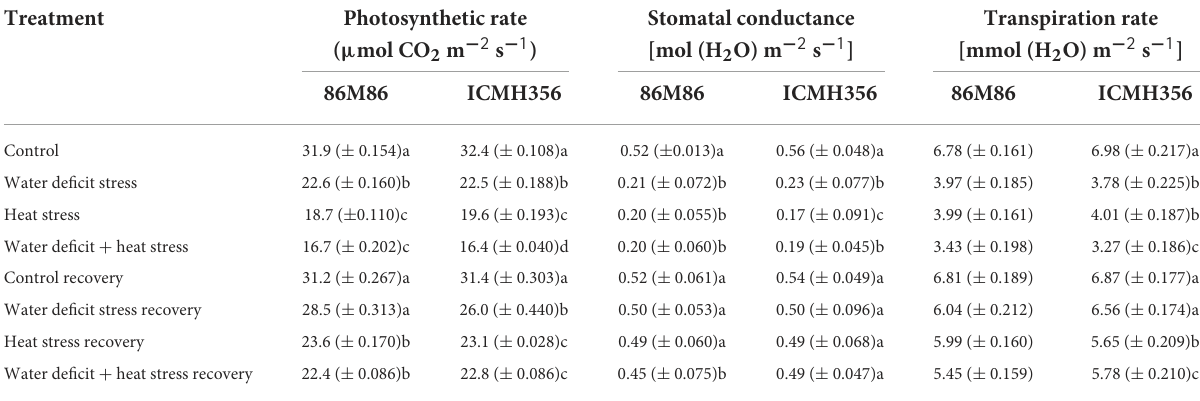
TABLE 2 The photosynthetic rate and gas exchange parameters in two varieties of pearl millet under water-deficit stress and heat stress in isolation and in combination and after recovery from stress.